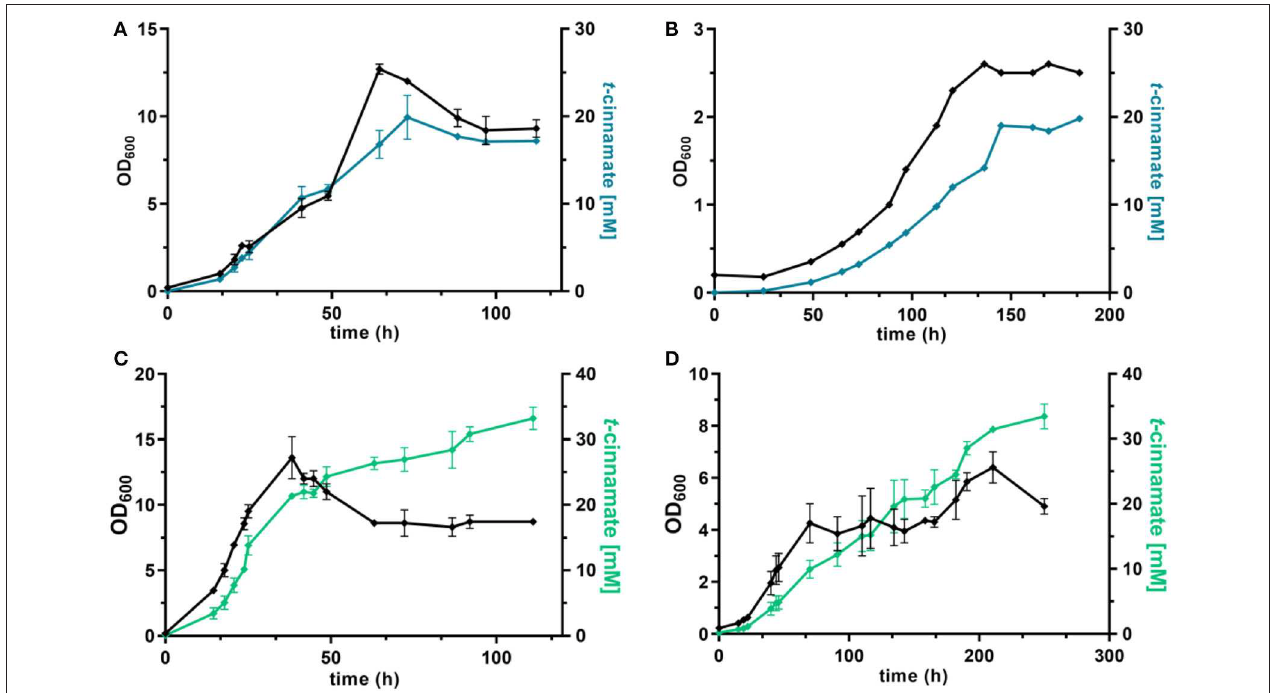
FIGURE 5 | dO 2 -stat fed-batch fermentations of t -cinnamate producing strains of P. taiwanensis . Cultivations were performed in MSM, where the initial batch medium contained either glucose or glycerol as sole carbon source and the subsequent feeding solution contained solely the respective carbon source. The top graphs show growth (black lines) and t -cinnamate accumulation (blue lines) during fermentation of P. taiwanensis GRC3 1 8 1 pykA -tap attTn7::P 14 g AtPAL- aroG fbr -pheA T 310 on glucose (A) and glycerol (B) . The glycerol figure (B) displays data of a single reactor. The bottom graphs represent growth (black lines) and t -cinnamate accumulation (green lines) during fermentation of P. taiwanensis GRC3 1 8 1 pykA -tap attTn7::P 14 f AtPAL on glucose (C) and glycerol (D) . The error bars represent the standard error ( n =